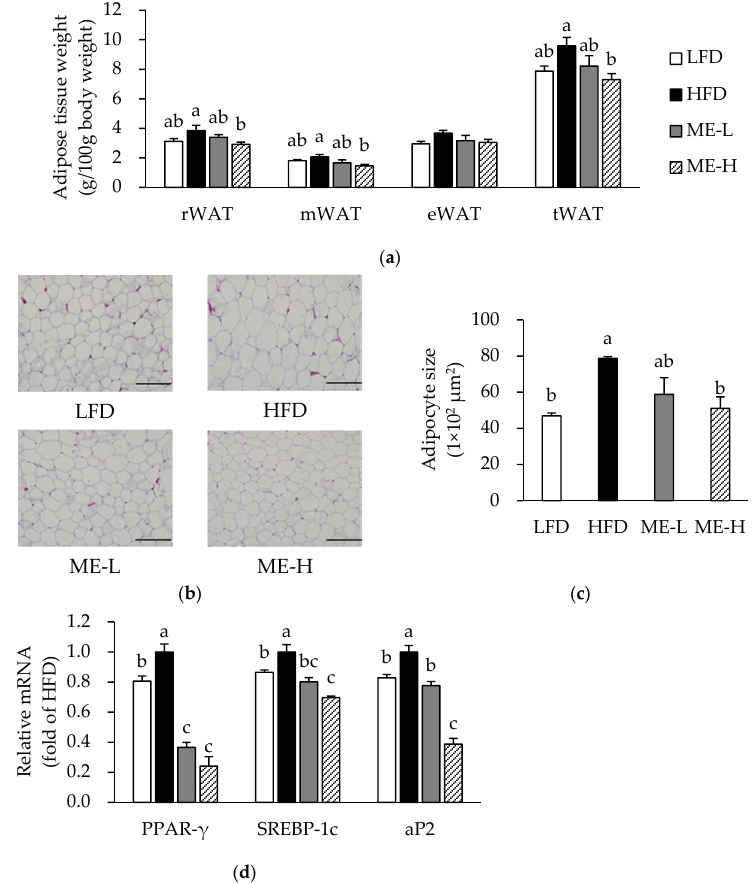
Figure 1. Effect of mulberry fruit extract on adiposity. ( a ) The relative weight of adipose tissue. ( b ) Representative images of hematoxylin and eosin (H&E)-stained sections of white adipose tissue. Magnification of 200. Scale bars = 200 μ m. ( c ) Average adipocyte size. ( d ) mRNA expression of adipogenic genes in white adipose tissue. The mRNA levels were normalized relative to the β -actin. Values are expressed as mean ± SEM (n = 8/group). Bars with different letters indicate a significant difference at p < 0.05. Abbreviations: LFD, low-fat diet; HFD, high-fat diet; ME-L, HFD + 5 g/kg diet of mulberry fruit extract; ME-H, HFD + 10 g/kg diet of mulberry fruit extract; rWAT; retroperitoneal white adipose tissue; mWAT, mesenteric white adi- pose tissue; eWAT, epididymal white adipose tissue; tWAT, total white adipose tissue; PPAR- γ , peroxisome proliferator- activated receptor- γ ; SREBP-1c, sterol regulatory element-binding protein-1c; and aP2, adipocyte protein 2.